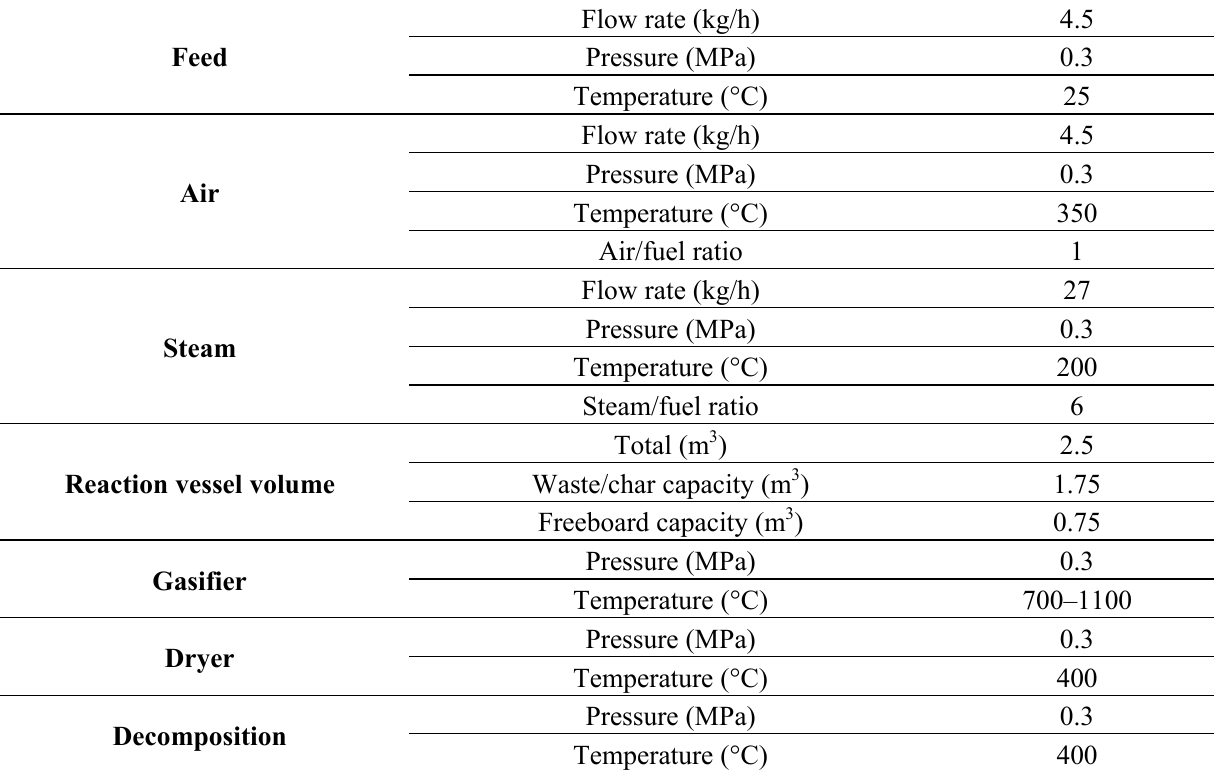
Table 4. Gasifier operating